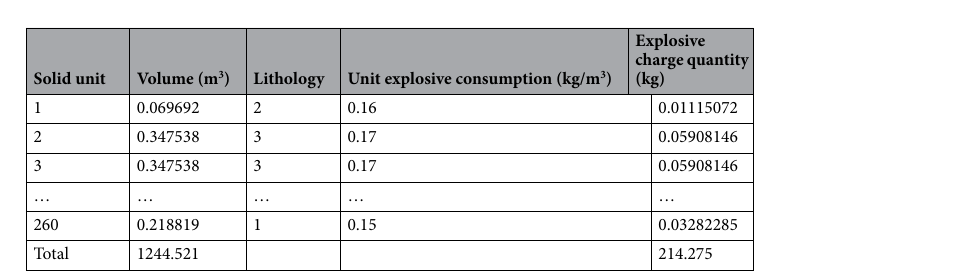
Figure 12. Rock column entity affected by blast hole: ( a ) the influence rock column entity of all blast holes; ( b ) the influence rock column entity of ZK2032 blast hole.